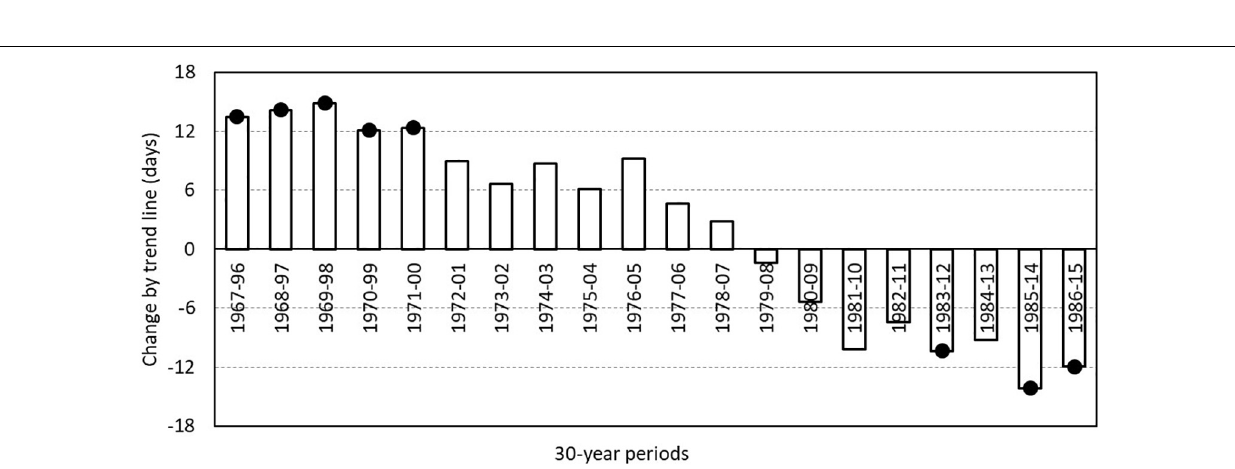
FIGURE 5 | Running trends of frequency (in days) of CAP09 classification circulation type W for 30-year periods. Statistically significant ( p < 0.05) trends are marked with black dots.